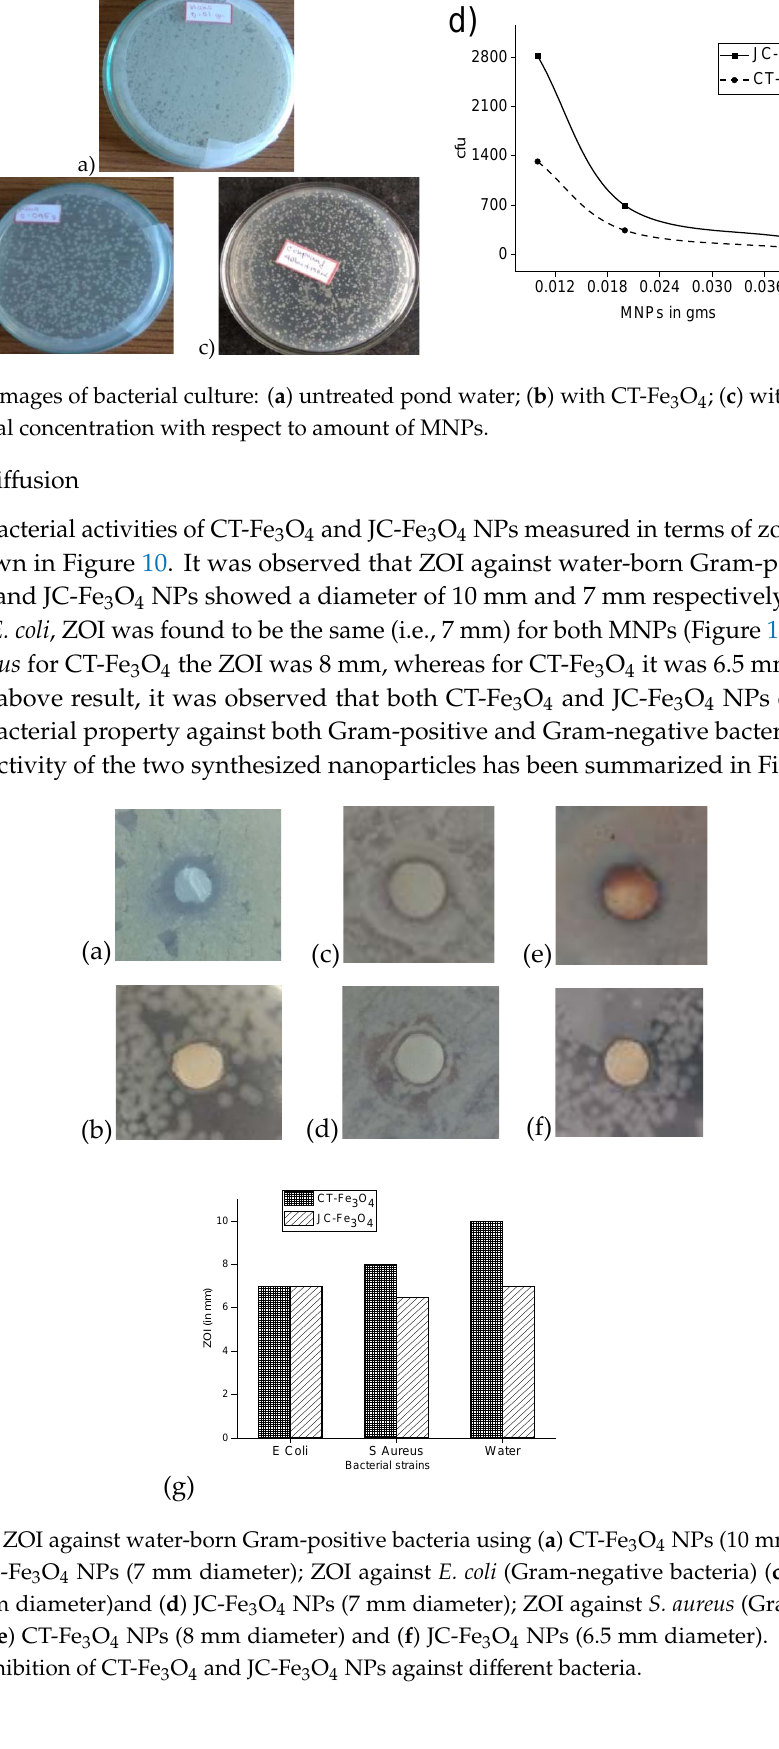
3 O 4 and JC-Fe 3 O 4 NPs were examined. The amount of